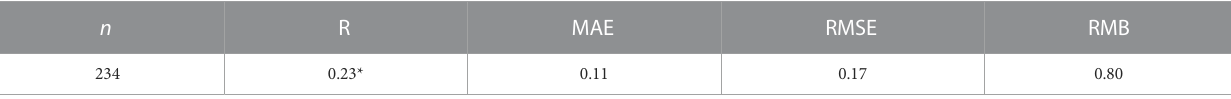
TABLE 1 Statistics describing the relationship of daily averaged dust AOD between AERONET and simulation at Dalanzadgad (43.58 ° N, 104.42 ° E) station during spring from 2012 to 2014. n